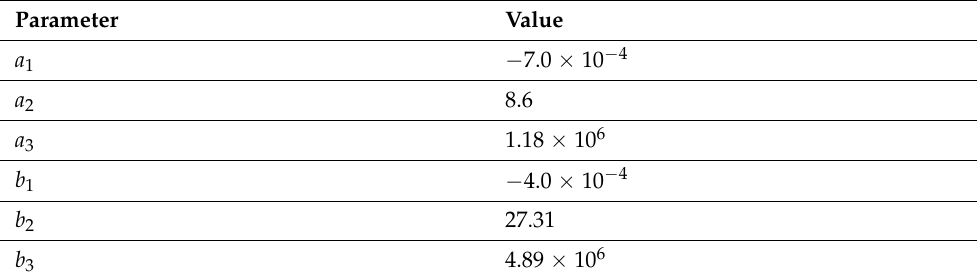
Table 1. Nonlinear suspension system parametric constants.